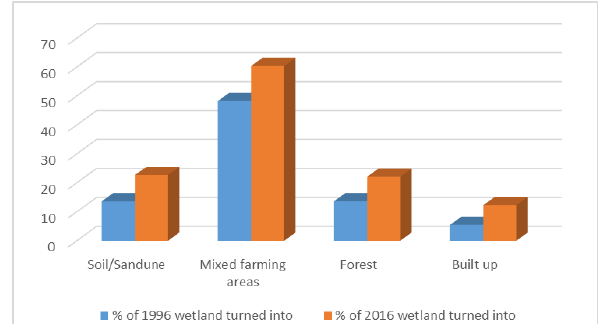
Figure 6. Wetland loss to other land uses/cover.